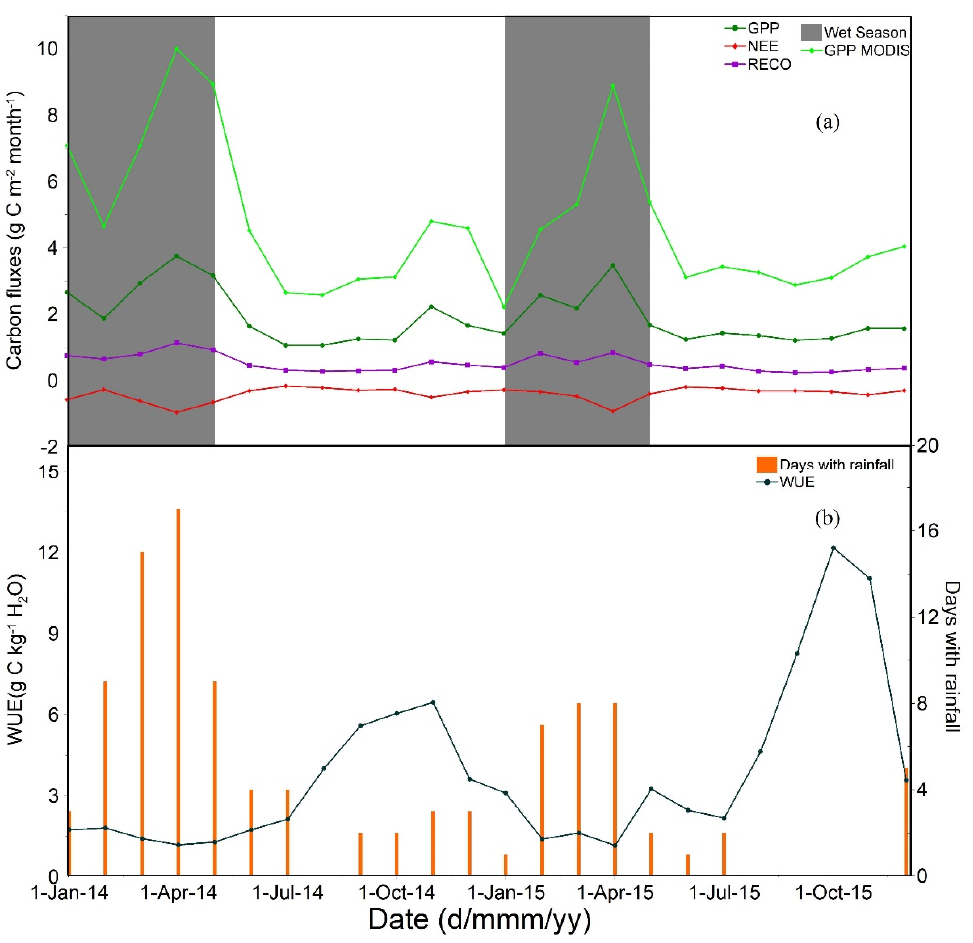
Figure 4. ( a ) Monthly averages of net ecosystem CO 2 exchange (NEE), gross primary production (GPP Tower and GPP MODIS), ecosystem respiration (Reco), and ( b ) water use efficiency (WUE) during 2014–2015 in the Caatinga (ESEC-Seridó). Orange bars ( b ) indicate the total number of rain days (days with registered rainfall) in each month.